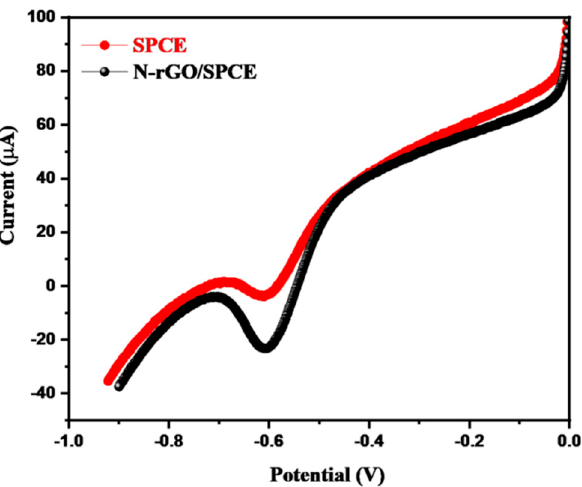
Figure 10. The LSV curves of SPCE (red) and N-rGO/SPCE (black) in the presence of 0.01 mM H 2 O 2 in 0.1 M PBS of pH 7.0 at a scan rate of 50 mVs − 1 .